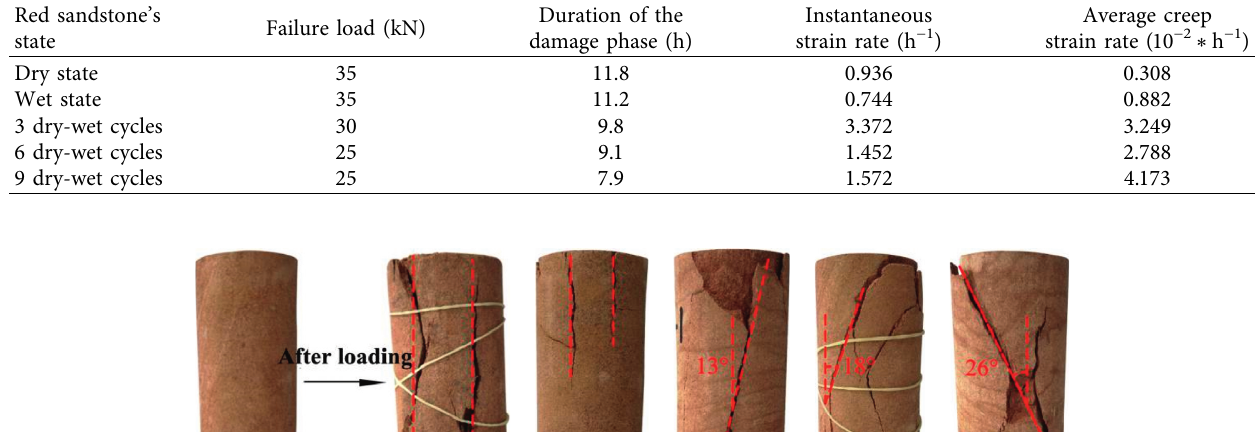
Table 5: Statistics of the creep parameters of the red sandstone under the failure load level.